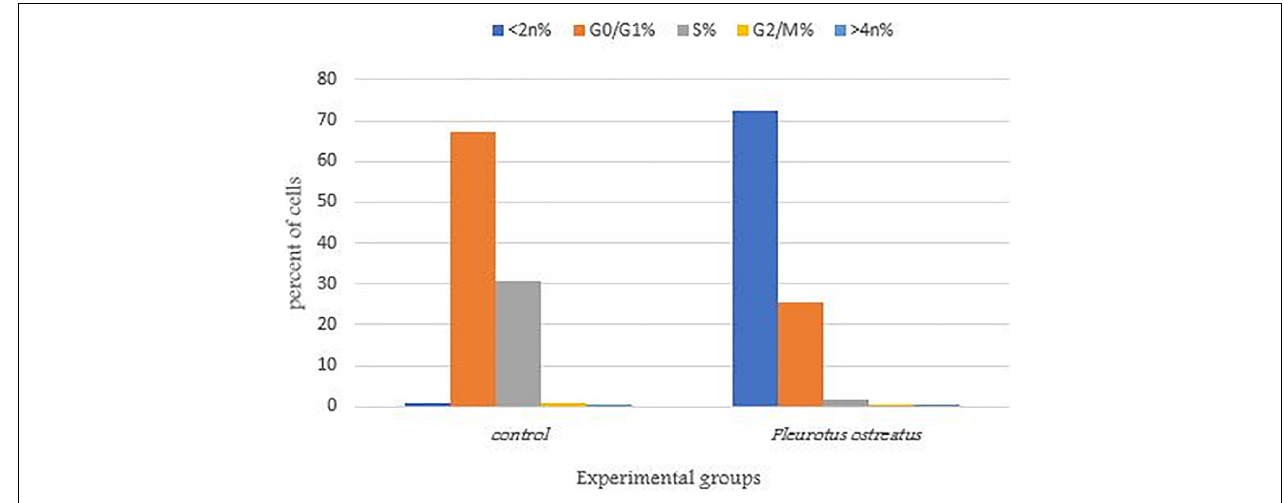
FIGURE 5 | MCF-7 cells distribution in the various cell cycle stages treated with PoPE. The representative diagram showed induction of sub- G1 phase arrest in MCF-7 cells after incubation for 24 h and treatment with the IC 50 (5 µ g/mL) of PoPE as examined by a Cytell TM cell imaging instrument.